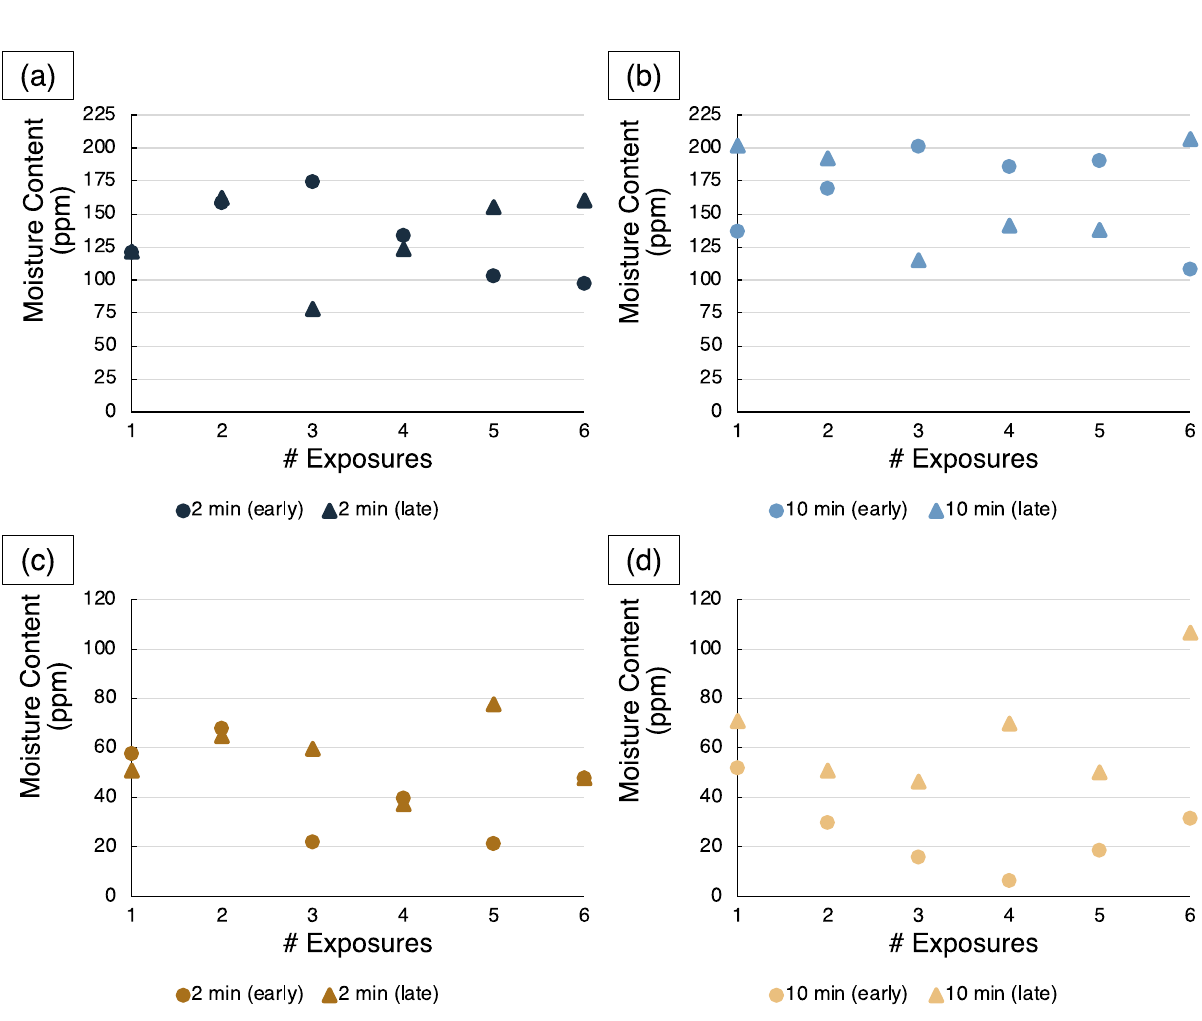
Figure 6. Moisture content (in ppm) of the Al 5056 powder at ( a ) 2 min and ( b ) 10 min exposure durations and the Ta powder at ( c ) 2 min and ( d ) 10 min exposure durations for the “early” and “late” exposures from Lots #1 through #6 and Lots #13 through #18, respectively, for each powder type.